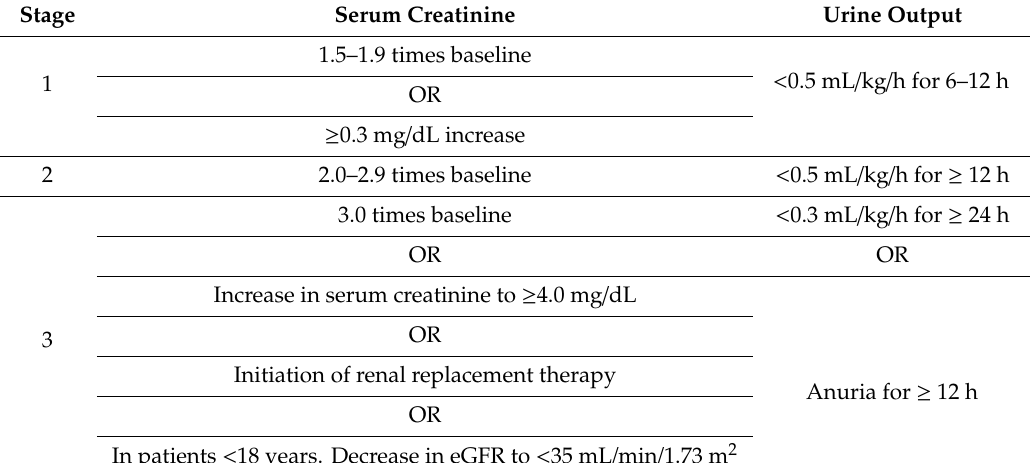
Table 1. KDIGO-2012 acute kidney injury (AKI) classification and